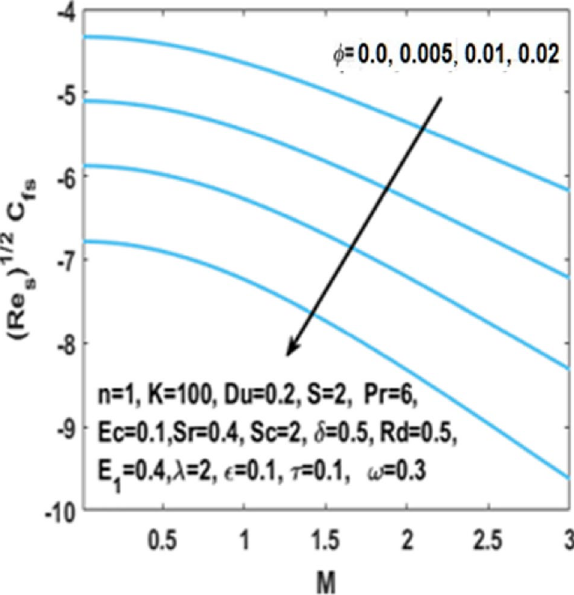
Figure 10. Impact of φ on skin friction w.r.t M .